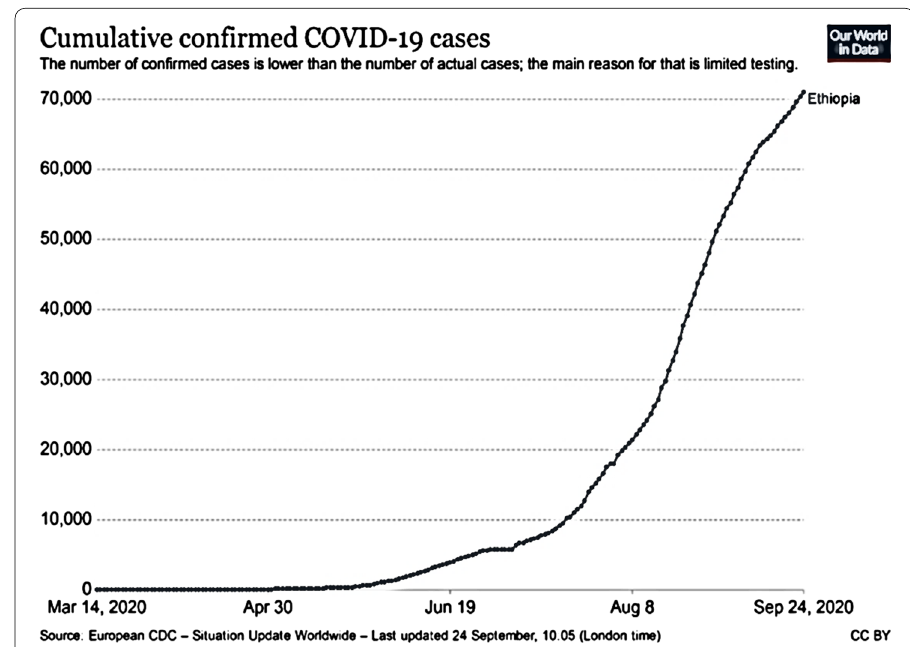
Fig. 1 Cumulative confirmed cases of COVID-19 in Ethiopia, up to Sep 24,